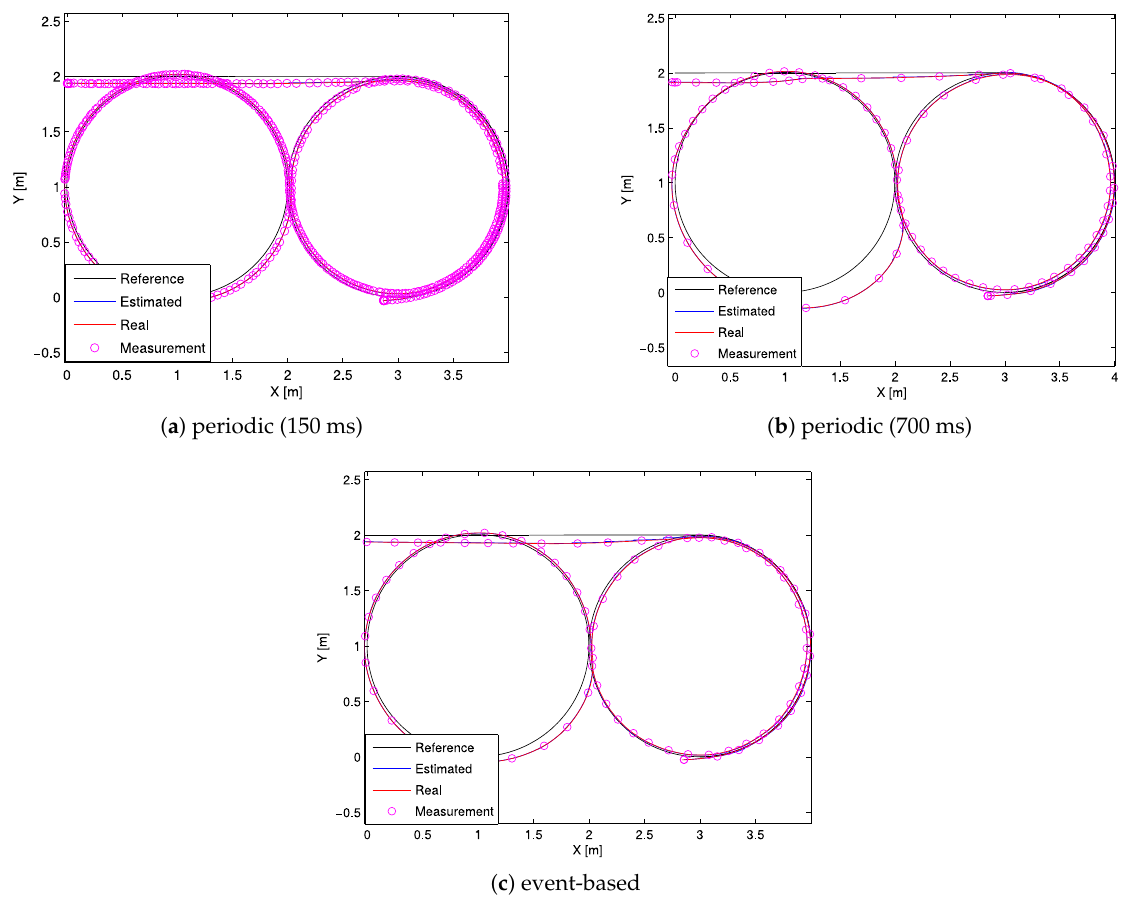
Figure 7. Robot trajectory developed during the